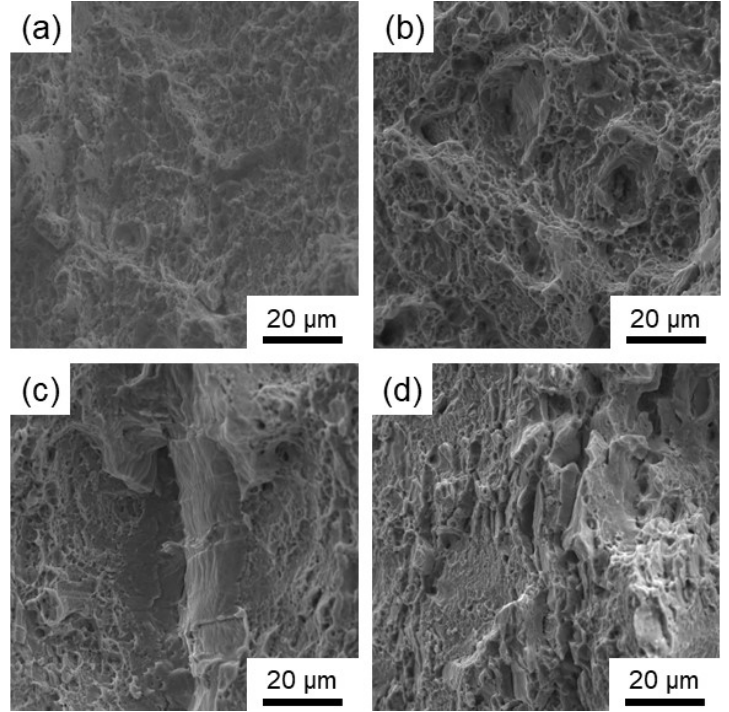
Figure 2. Fracture profile after tensile deformation: ( a ) S1000, ( b ) A450, ( c ) A500, ( d ) A550.